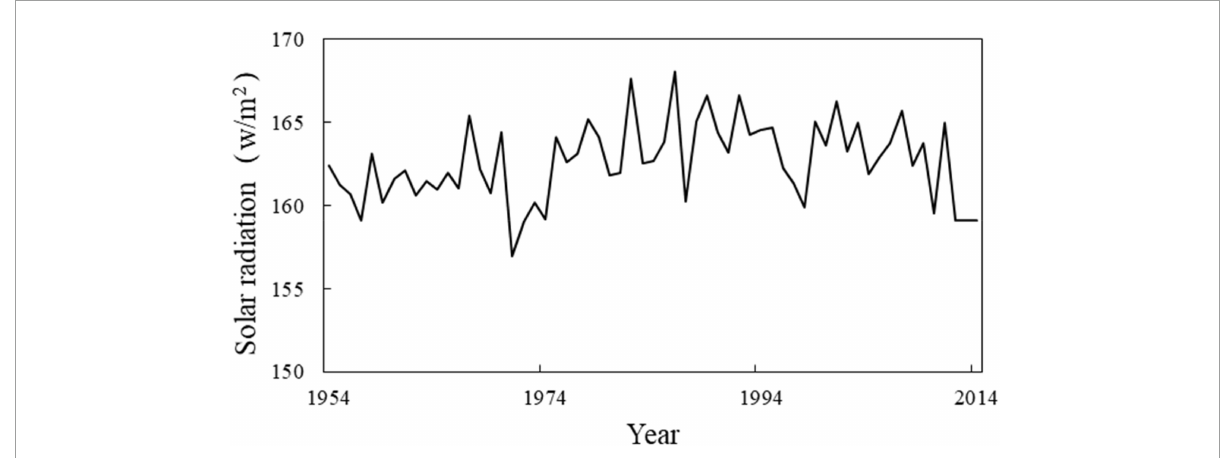
FIGURE6 Changes of solar radiation since 1954 in the Sanjiang